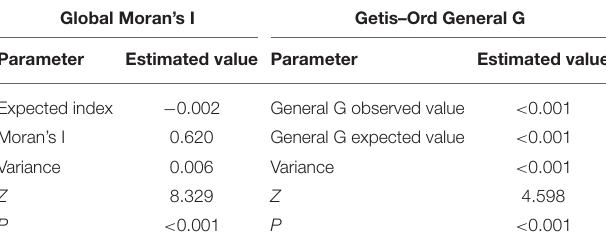
TABLE 2 | Summary of Global Moran’s I and Getis–Ord General G results. Global Moran’s